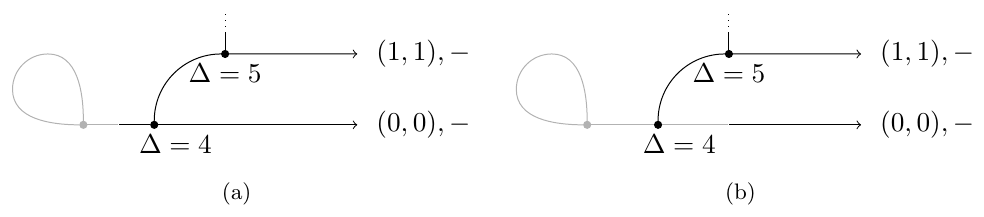
Figure 5 . Topology of (cid:6) near charged scalar sector with a gap. Left: the gap in scalar sector is less than 4. Right: the gap in scalar sector is greater than